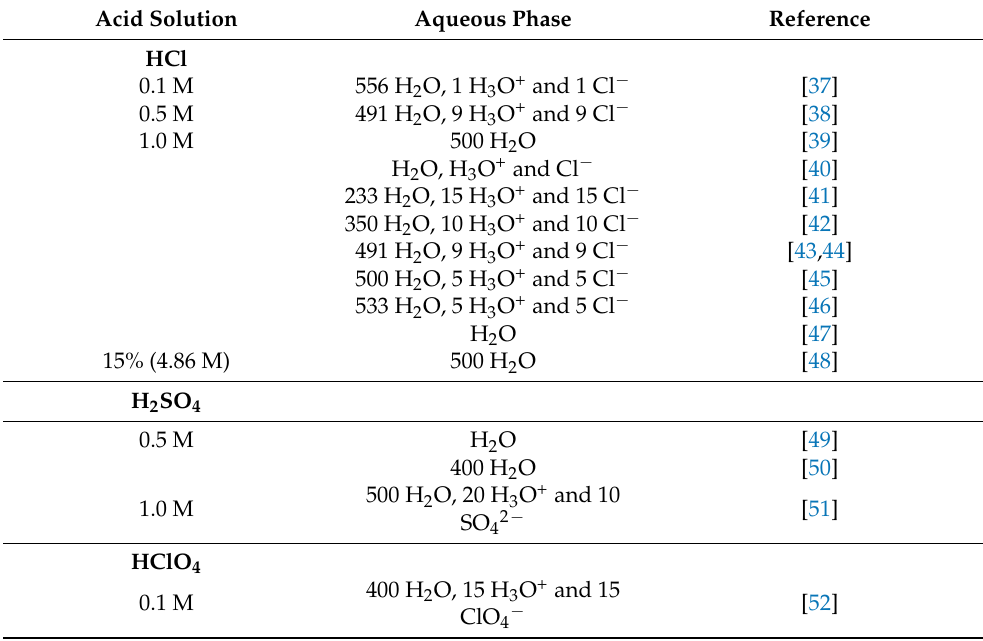
Table 1. Aqueous phase of acidic solution in MD simulation.